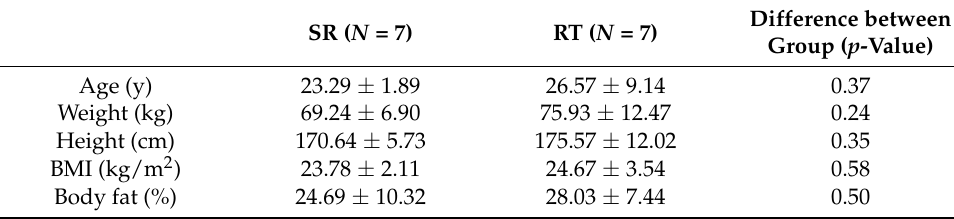
Table 1. Baseline characteristics of spot reduction (SR) and resistance training (RT)